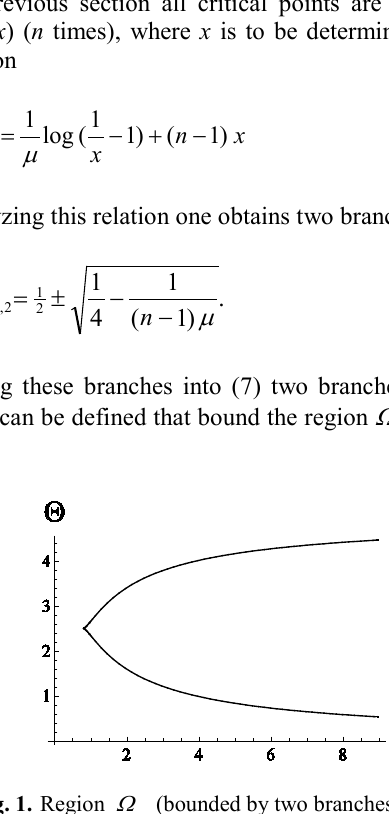
Fig. 1. Region Ω (bounded by two branches) for n=6